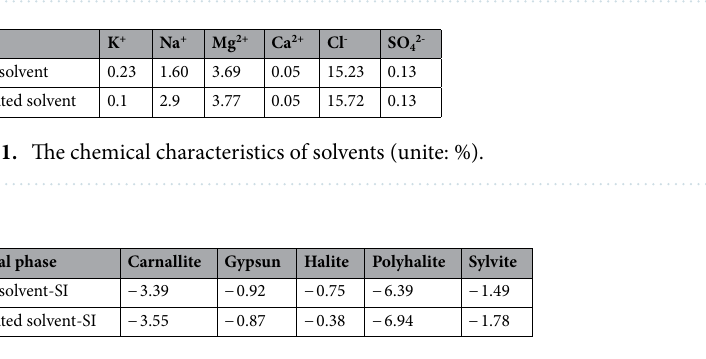
Table 2. The different SI in different